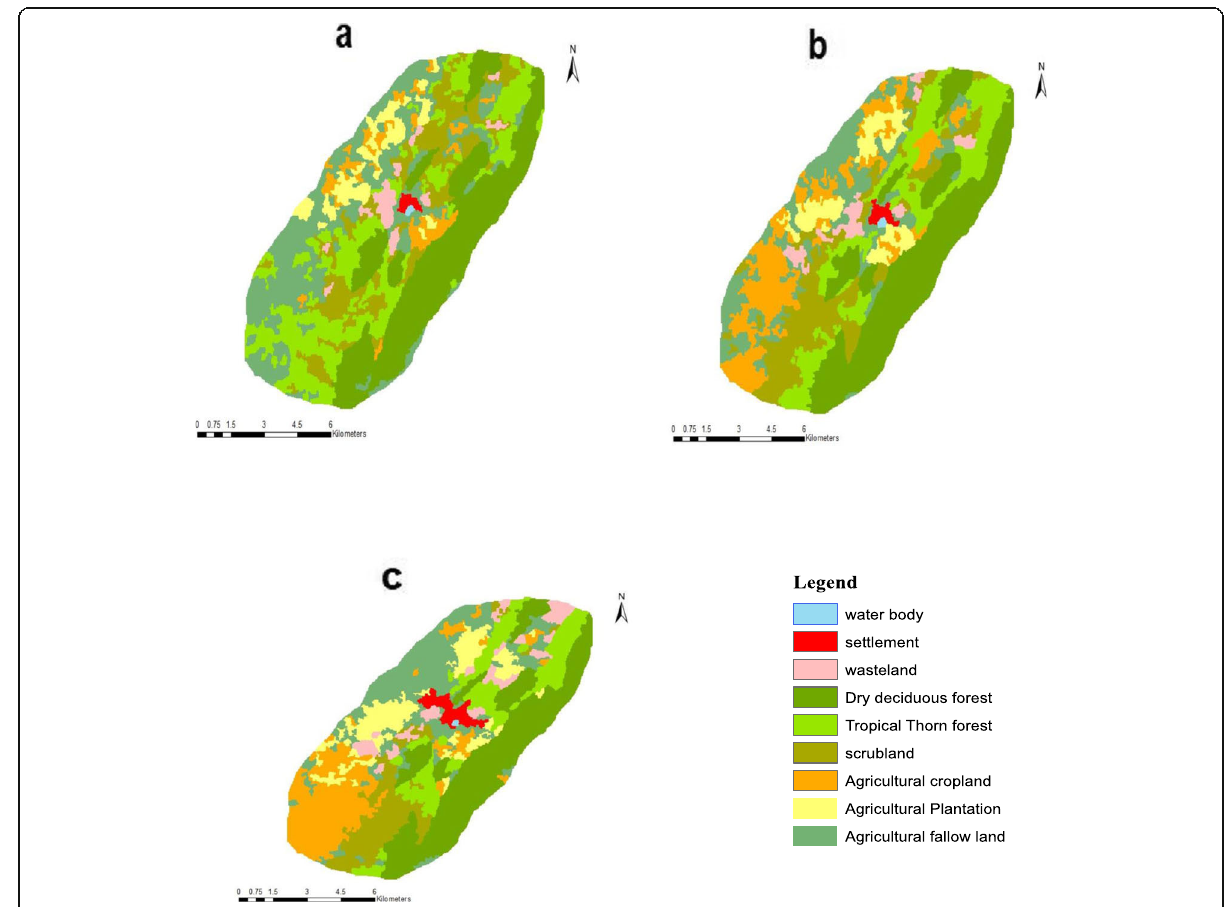
Fig. 5 Land use land cover maps of a 1993, b 2003, and c 2014